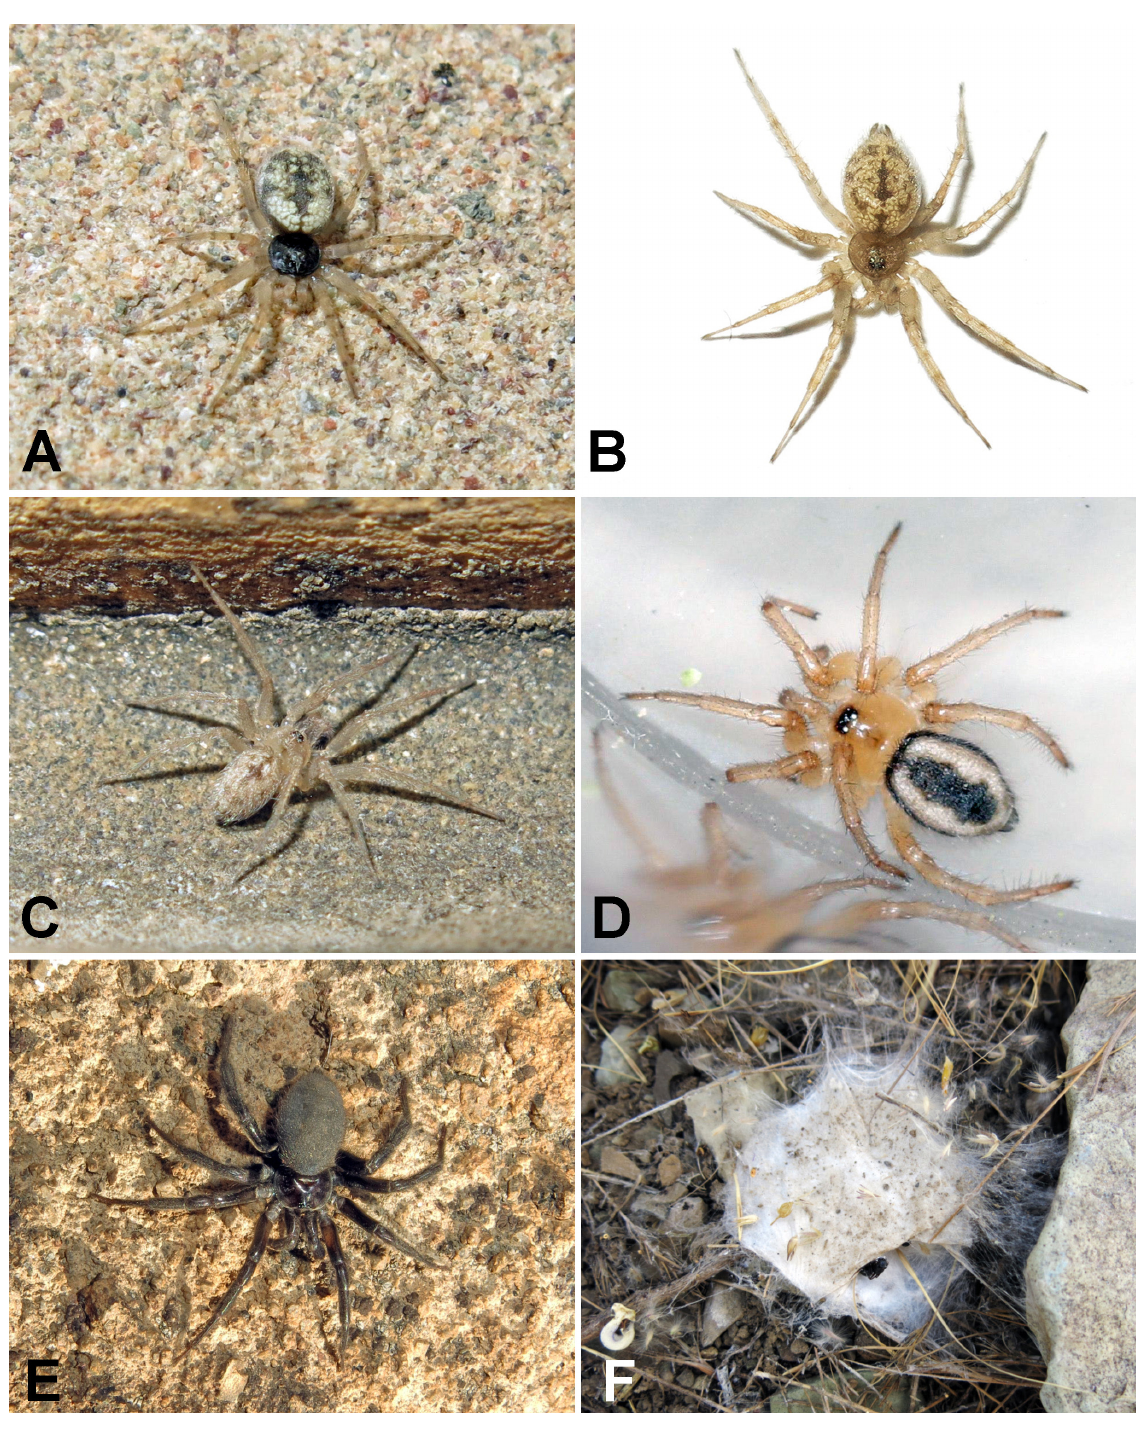
Fig. 3. Live habitus and tent web of oecobiids. A . Oecobius ferdowsii Mirshamsi, Zamani & Marusik, 2017, ♀. B . Oecobius nadiae (Spassky, 1936), ♀. C . Oecobius putus O. Pickard-Cambridge, 1876,